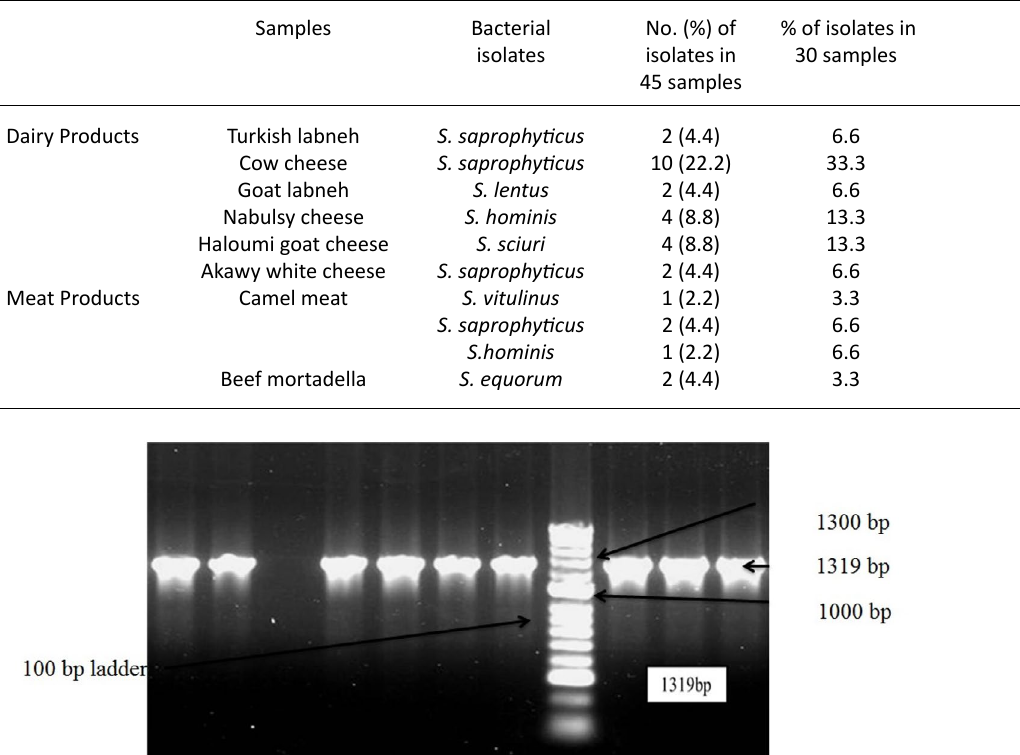
Fig. 2. Agarose gel electrolysis. The gel shows amplification of 1319 bp pair fragments of mec A gene. Lanes 1,2 (from left) shows coagulase negative, while lane 3 showing negative samples, and lane 8 shows 100bp ladder. Lanes 4,5,6,7,9,10,11 shows positive amplification of 1319 bp of Staphylococcus species harboring mec A